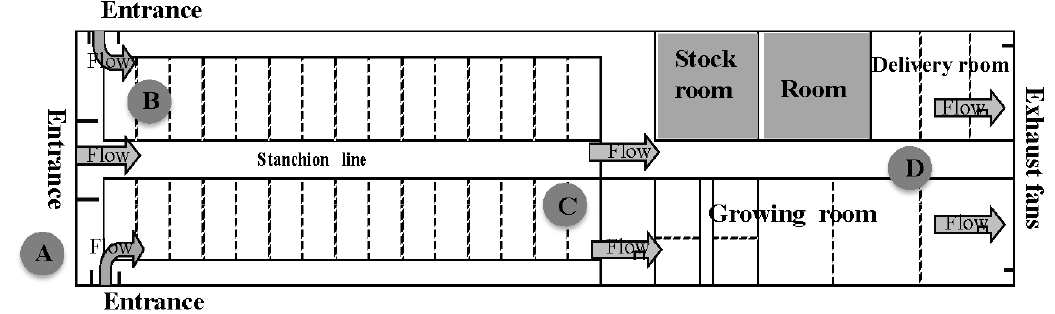
Figure 2. Schematic showing the location of sampling points in the cow shed for wind velocity, temperature and humidity. Sampling point (A) was outdoors, while (B, C, D) were